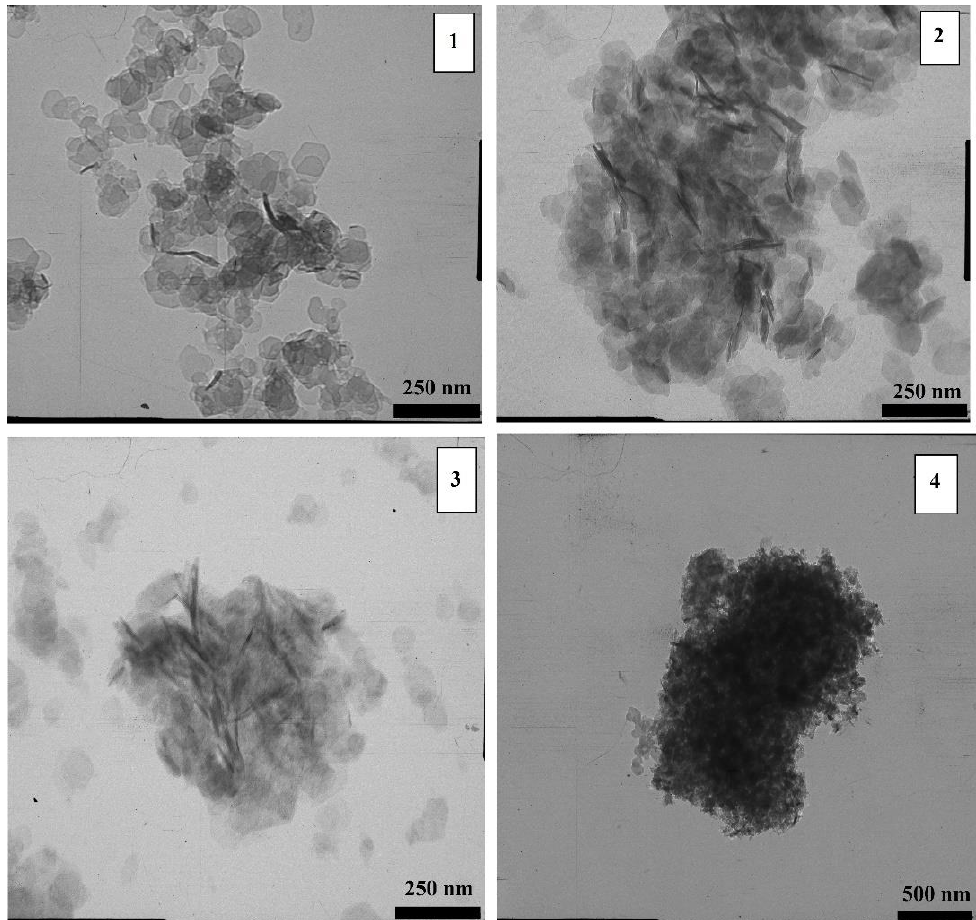
Figure 7. TEM micrographs of Mg/AlNi 25-ht heated at different temperatures: ( 1 ) RT, ( 2 ) 200 °C, ( 3 ) 400 °C, ( 4 ) 600 °C .